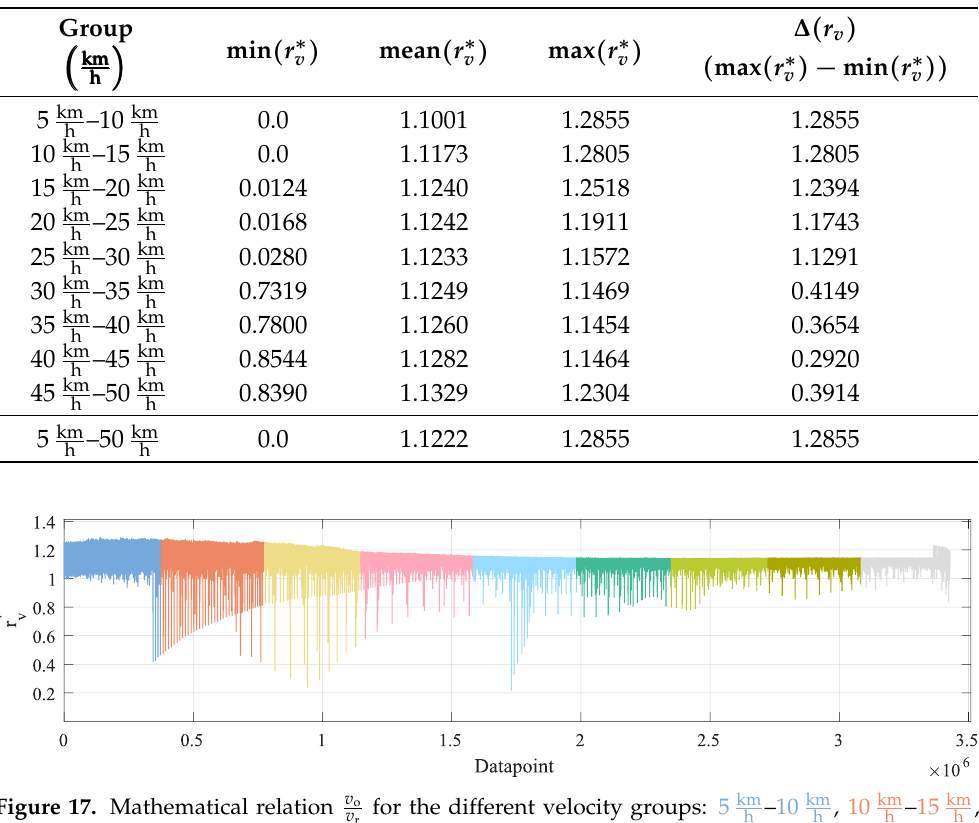
Figure 17. Mathematical relation v o for the different velocity groups: 5 km –10 km , 10 km –15 km , v r h h h h 15 km –20 km , 20 km –25 km , 25 km –30 km , 30 km –35 km , 35 km –40 km , 40 km –45 km , 45 km –50 km h h h h h h h h h h h h h h